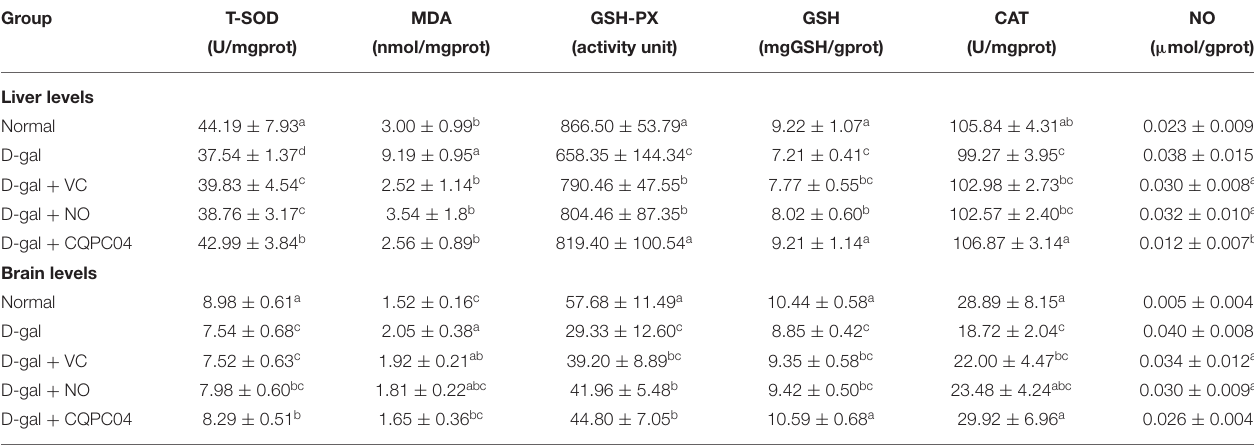
TABLE 3 | Levels of oxidative indicators in liver and brain of D-gal induced aging mice.